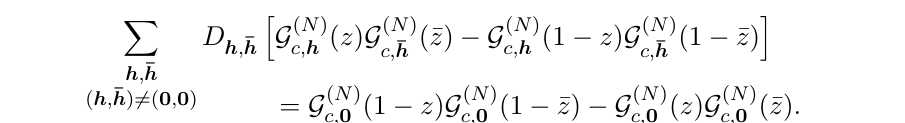
Figure 4 . The continuous lines represent the points in the ( h 2 , h 3 ) plane that satisfy the equation 0 ) ( h ) = 0 for c = 4 and h = 0 . 1 and several values of the truncation levels L, L 0 , W ( L,L c 1 , h 2 , h 3 1 see eq. (5.25). The dashed lines are the points that satisfy the same equation but removing from 0 ) ( h ) the sums with coefficients A 0 . This is the approximation considered in ref. [28]. W ( L,L c 1 , h 2 , h 3 l The colouring of the dashed lines corresponds to take different upper bounds L in the sums with coefficients A . The panels b and c are the magnification of the regions indicated by a box in the plot l